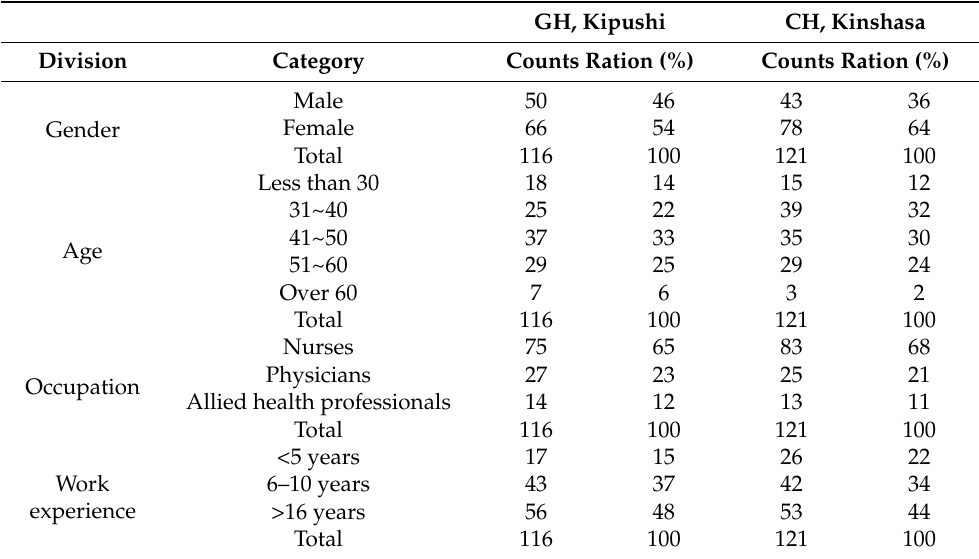
Table 1. Parameters of the participants regarding the noise